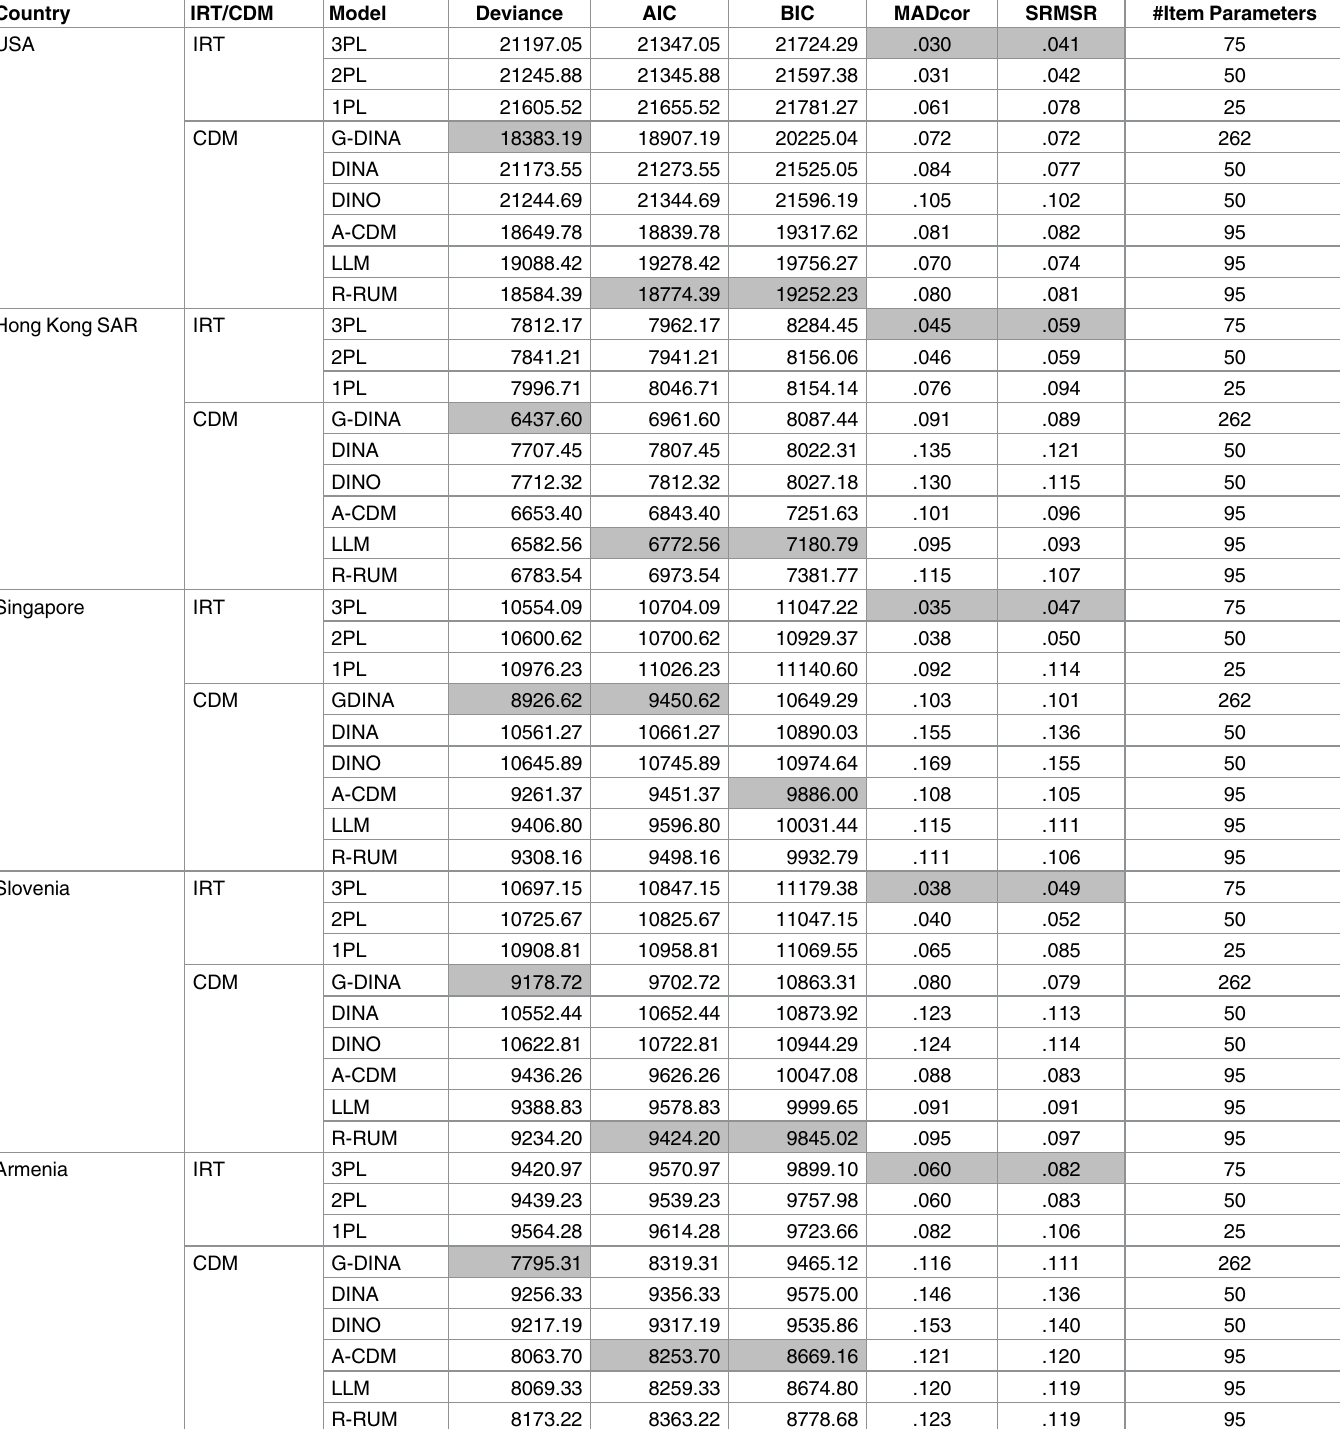
Table 5. Comparison of IRT models and CDMs in each country.